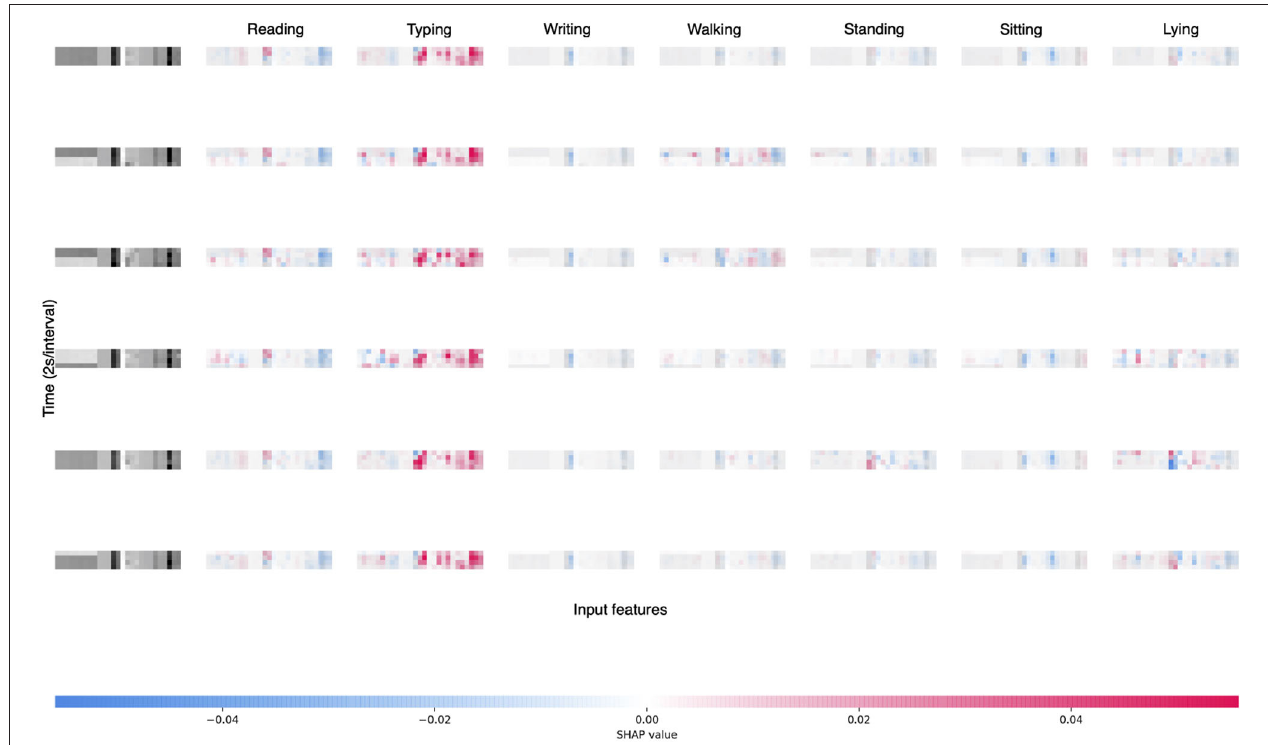
FIGURE 10 | SHAP values of six samples of different classes. The subfigures in the first column are the inputs of the samples, and the subfigures from the second to the last columns represent the seven classes in the order of L_N, Re, Si_N, St_N, Ty, W_N,